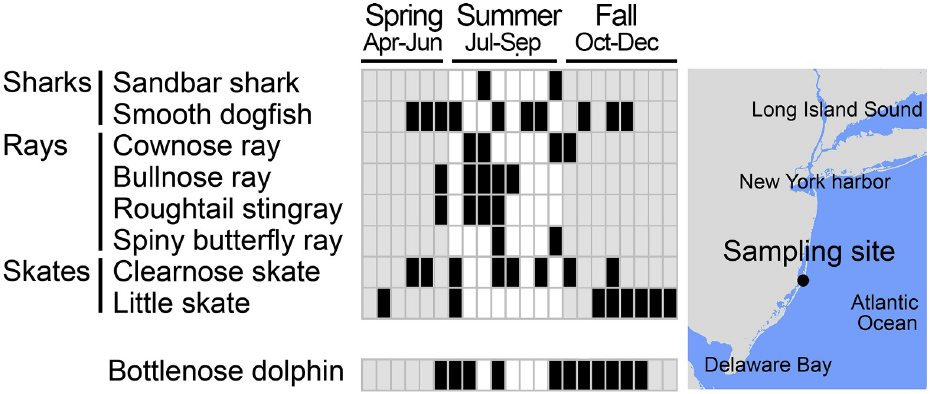
Fig 4. GoFish detections of cartilaginous fishes and bottlenose dolphin eDNA. Water samples were collected at one- to two-week intervals from April to December 2017 in southern New York Bight. Black indicates a GoFish detection, white or gray indicates no detection. The gray shading is added to help visualize demarcation of